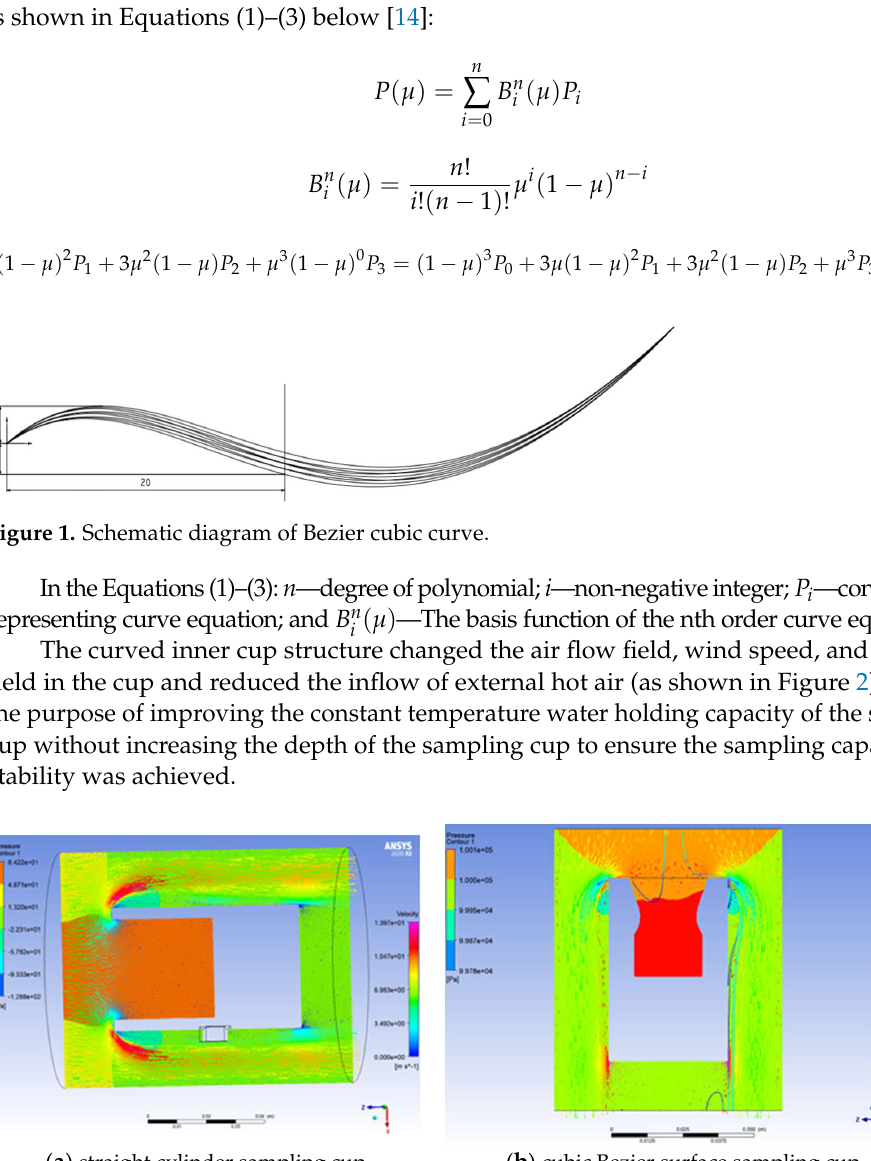
Figure 2. Comparison of pressure field and wind speed field between straight cylinder sampling cup and curved sampling cup.